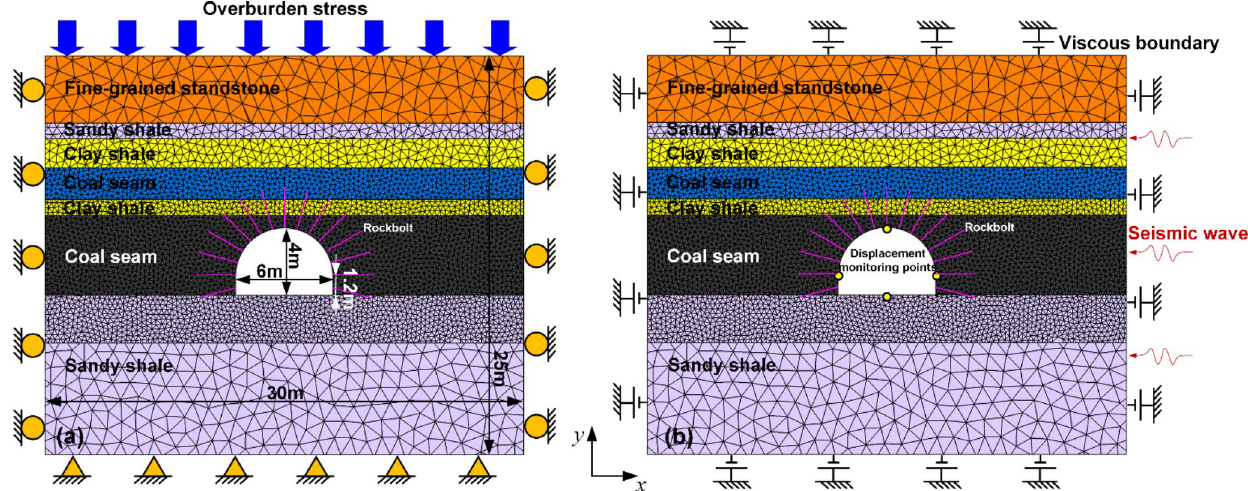
Fig. 3 2D numerical model of a deep tunnel. a Static stage; b Dynamic